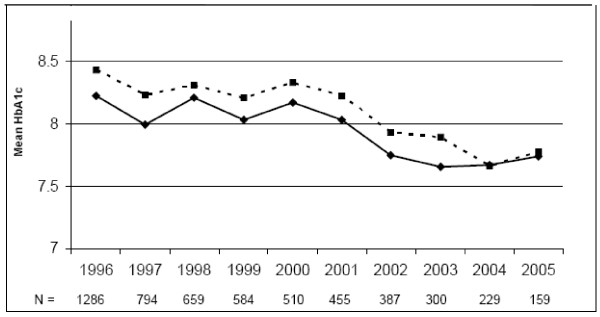
Annual mean HbA1c from 1996-2005, comparing longitudinal (solid line, n = 1772 in all years) vs. lost to follow-up (dashed line, number if remaining patients for each year provided below graph).